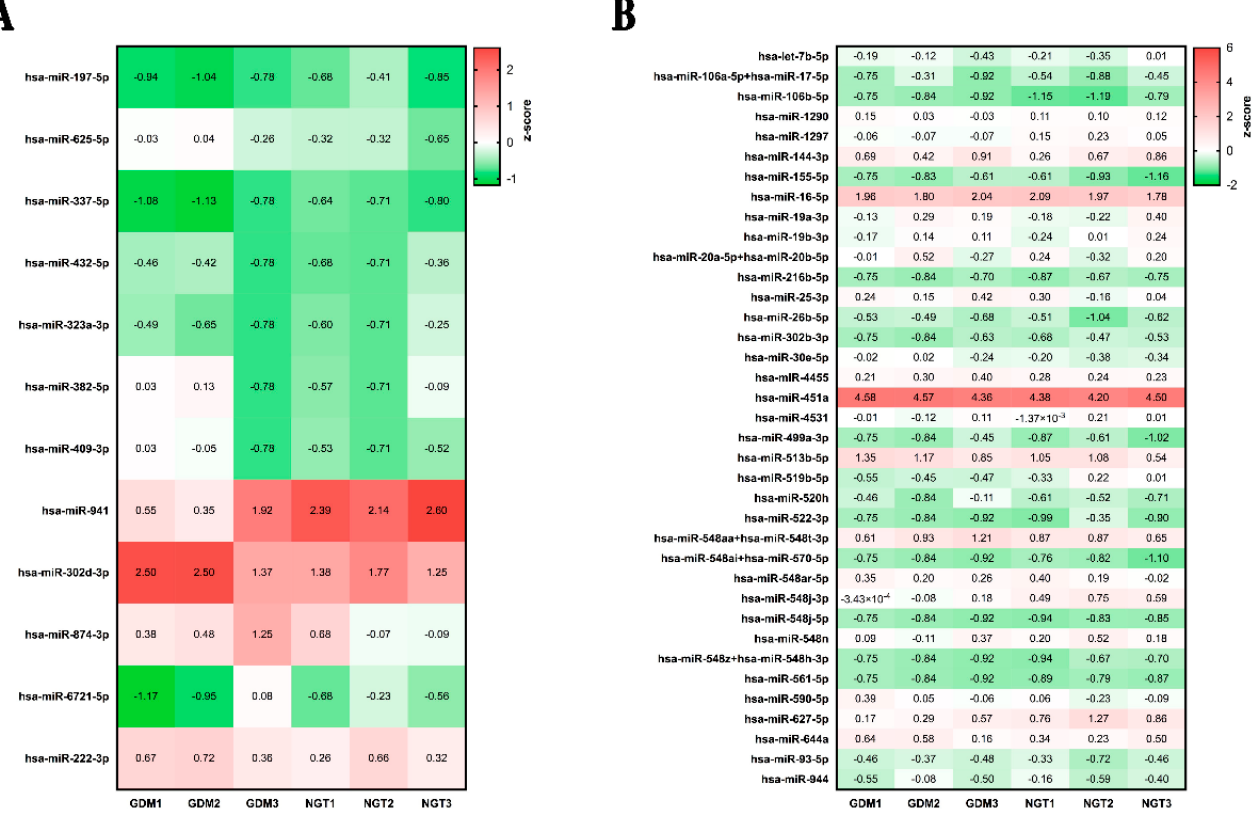
Figure 1. Analysis of differentially expressed (DE) miRNAs in GDM vs. NGT patients of the discovery cohort. Hierarchical clustering analysis of the DE miRNAs in total plasma ( A ) and EVs ( B ) of GDM ( n = 3) and NGT ( n = 3) patients demonstrates the miRNAs different expression pattern between the two subgroups.